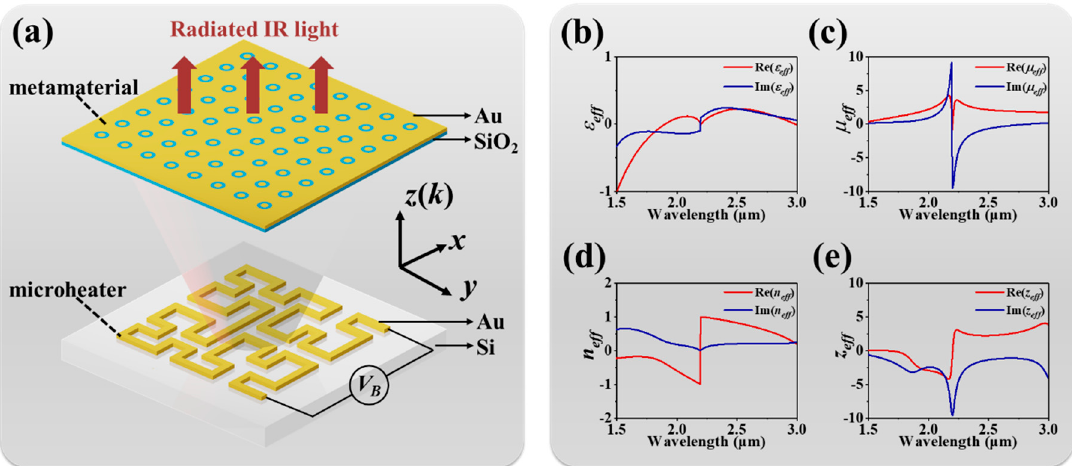
Figure 1. ( a ) Schematic drawing of tunable IR (infrared) emitter. The calculated ( b ) effective permittivity, ( c ) effective permeability, ( d ) effective refraction index, and ( e ) effective impedance index of the metamaterial.